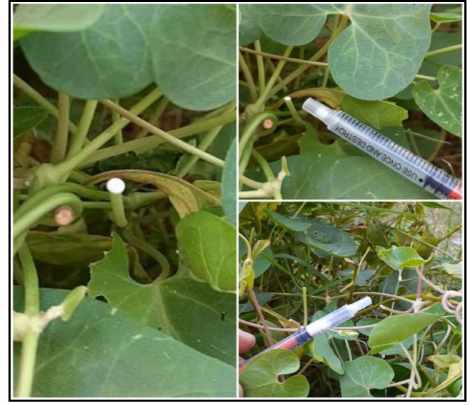
Figure 13. Latex collection from C. acutum